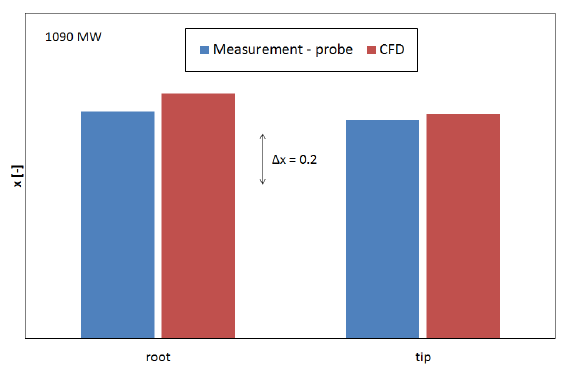
Figure 11. Absolute Mach number in Plane